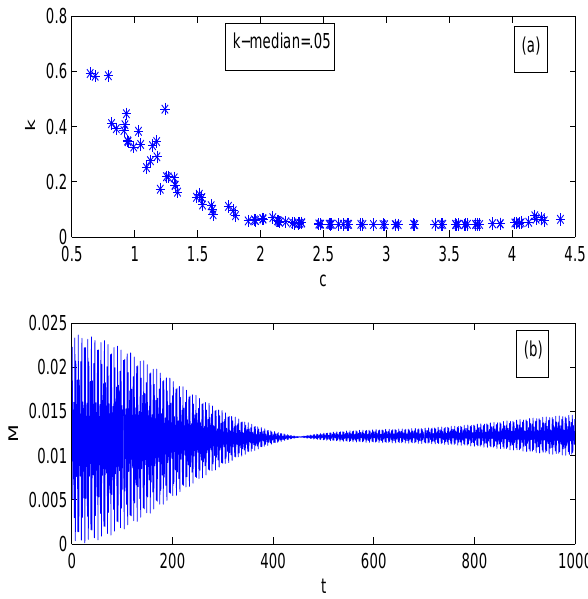
Fig. 4. (a) corresponds to the value of k as a function of c , with the median value shown in the box, and (b) is a plot of M(n) which shows a constant value and hence the slope is zero.